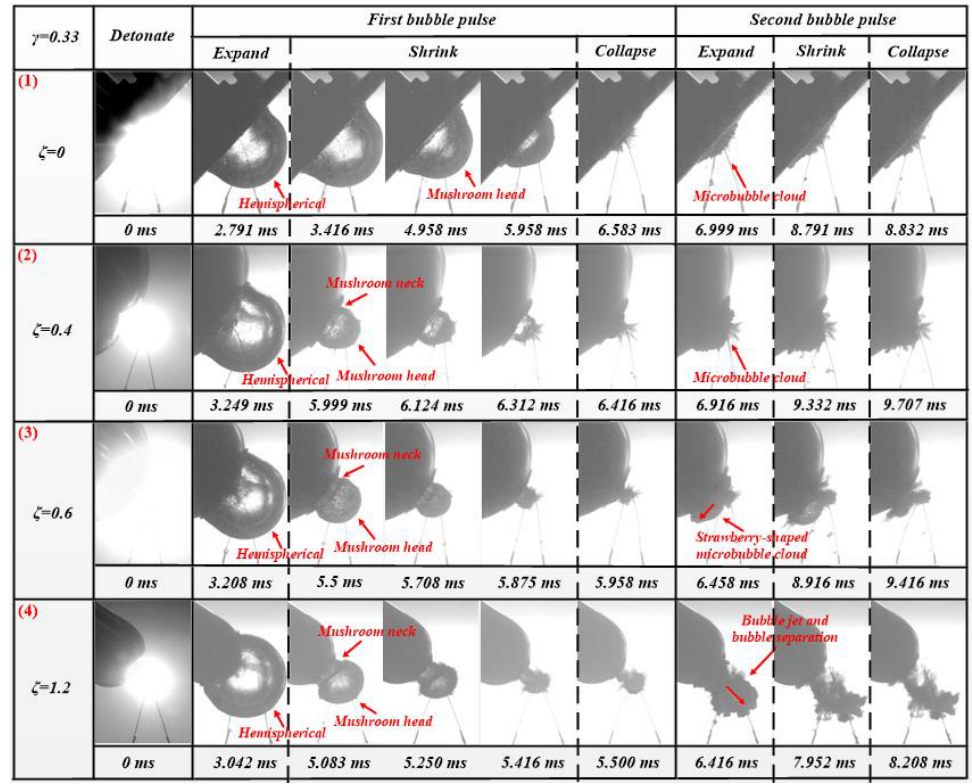
Figure 7. Type I bubble pulsation process diagram. ( 1 ) The bubble pulsation process when ζ = 0 and γ = 0.33. ( 2 ) The bubble pulsation process when ζ = 0.4 and γ = 0.33. ( 3 ) The bubble pulsation process when ζ = 0.6 and γ = 0.33. ( 4 ) Bubble pulsation process when ζ = 1.2 and γ = 0.33.